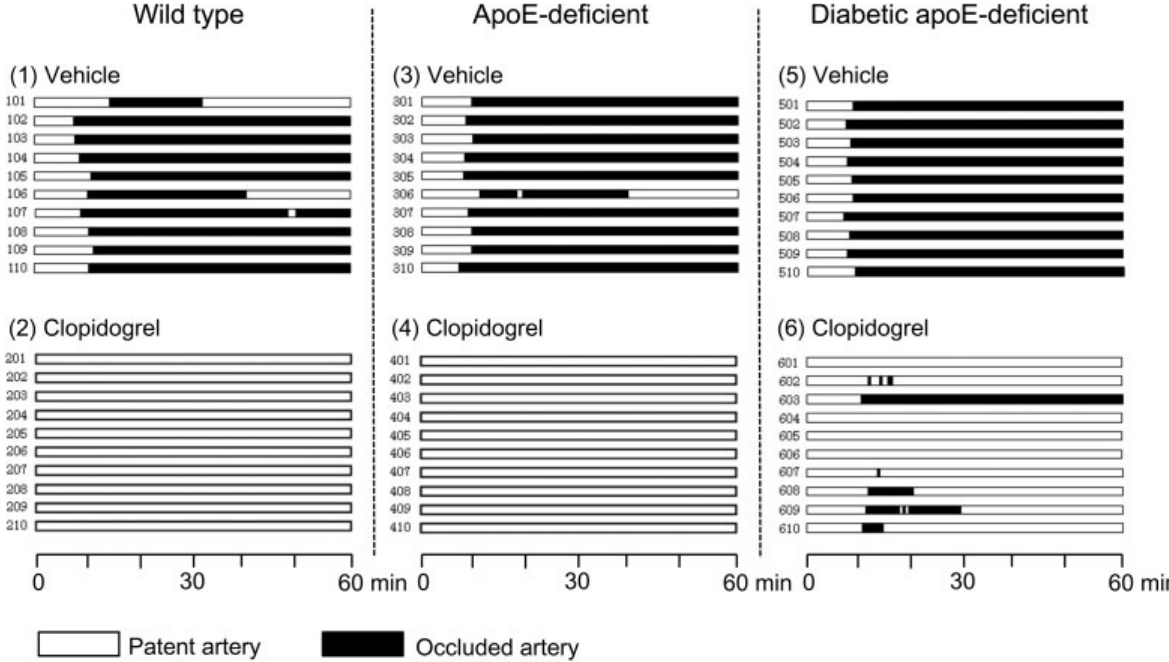
Fig. 1 Effects of clopidogrel on the patency of carotid arteries. Clopidogrel (10 mg/kg/d, orally) or vehicle was administered once daily for 5days. Carotidarteryocclusion was initiatedby application of FeCl 3 and blood fl ow was determined for 1 hour. Individual patency data are shown for vehicle-treated WT (1), clopidogrel-treated WT (2), vehicle-treated apoE-de fi cient (3), clopidogrel-treated apoE-de fi cient (4), vehicle-treated diabetic apoE-de fi cient (5), and clopidogrel-treated diabetic apoE-de fi cient groups (6). Open and fi lled bars indicate patent and occluded arteries, respectively. The number on the left side of each column represents animal ID number. apoE, apolipoprotein E; WT, wild-type.